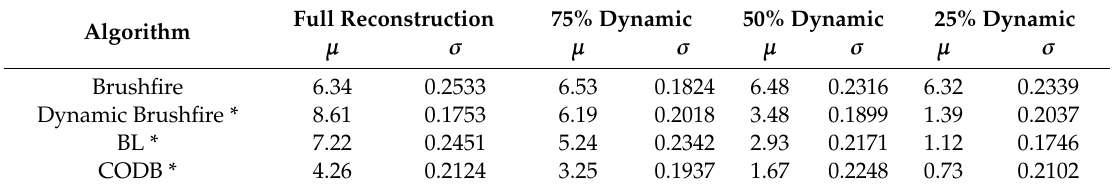
Table 7. Comparison of the algorithms’ e ffi ciencies in the four scenarios (milliseconds). Full Reconstruction Algorithm